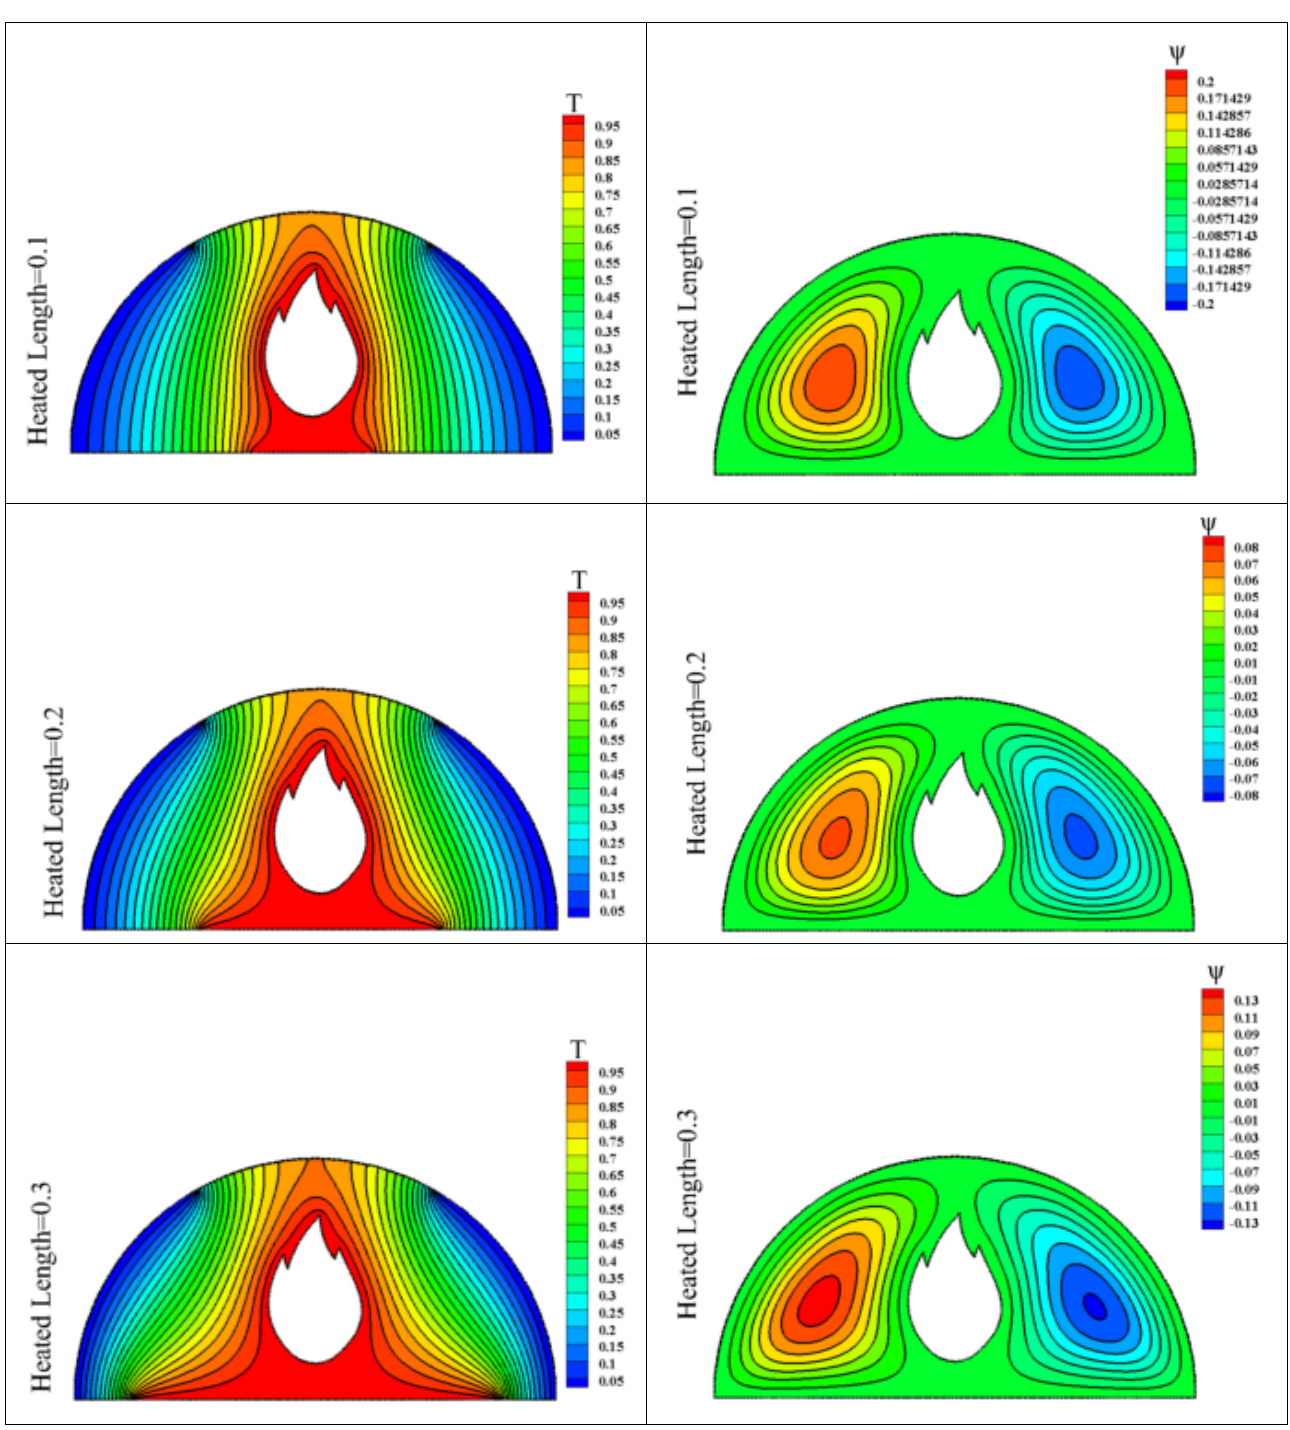
Figure 7. Streamlines ( right ) and isotherms ( left ) for various values of heated region length in the bottom of the hexagonal enclosure at ( φ = 0.02, Ha = 50, Rd = 0.5, Da = 10 − 4 and Ra = 10 5